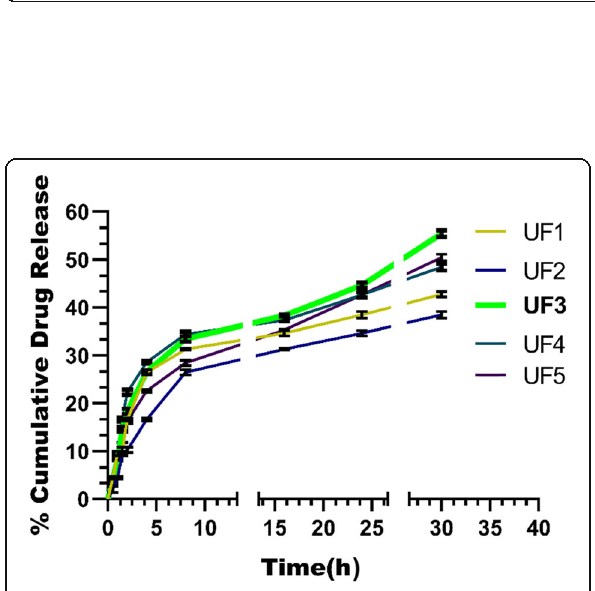
Fig. 4 In vitro drug release profile of different batches of ufasomes (UF1 – UF5). The values were articulated as mean ± SD ( n =